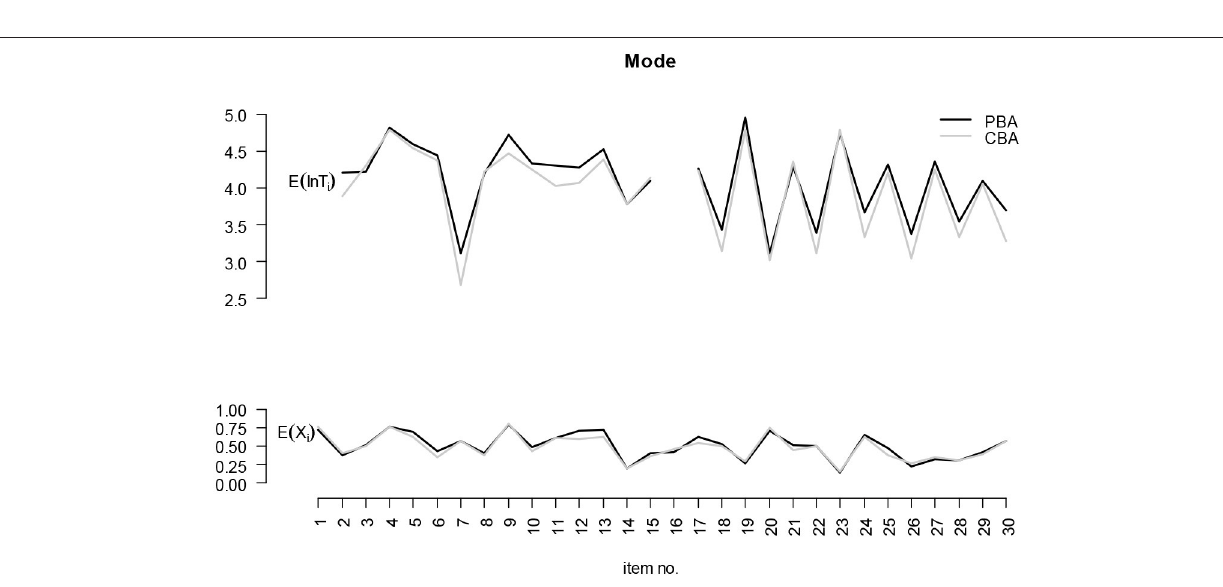
FIGURE 4 | Mode differences with respect to the log-response time and the proportion correct